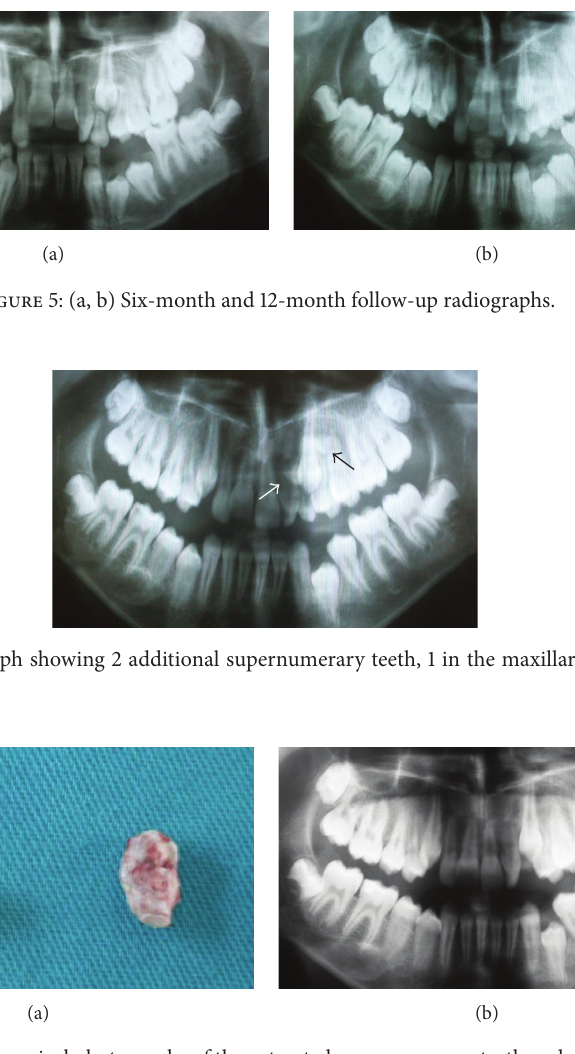
Figure 7: (a, b) Postsurgical photographs of the extracted supernumerary teeth and panoramic